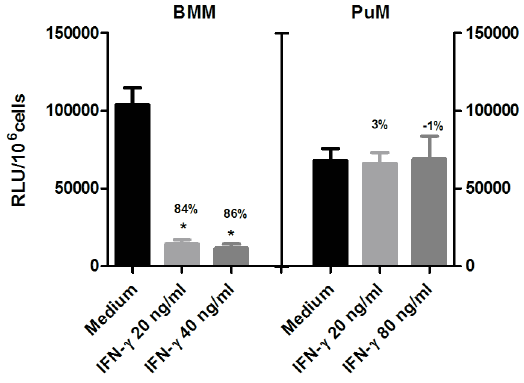
Figure 1. Impaired intracellular control of BCG growth by PuM upon IFN- c treatment. BMM and PuM were infected with GFP-BCG. After infection, cells were left untreated or treated with IFN- c (20, 40 and 80 ng/ml) for 48 h. Bacterial growth was evaluated by determining RLU. Data are shown as % reduction of phagocytosed bacteria evaluated as RLU. Values are means 6 SD of the mean of a representative experiment from 3 independent experiments with 4 replicates each. The differences between groups of BMM and PuM were analyzed using a one-way ANOVA followed by Bonferroni‘s Multiple Comparison Test, * significantly different from medium control, P , 0.05.